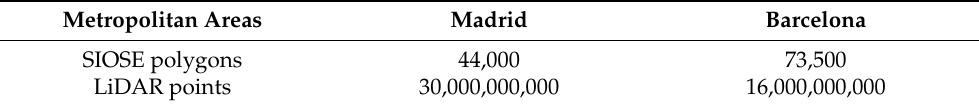
Table 1. Starting spatial data used in the